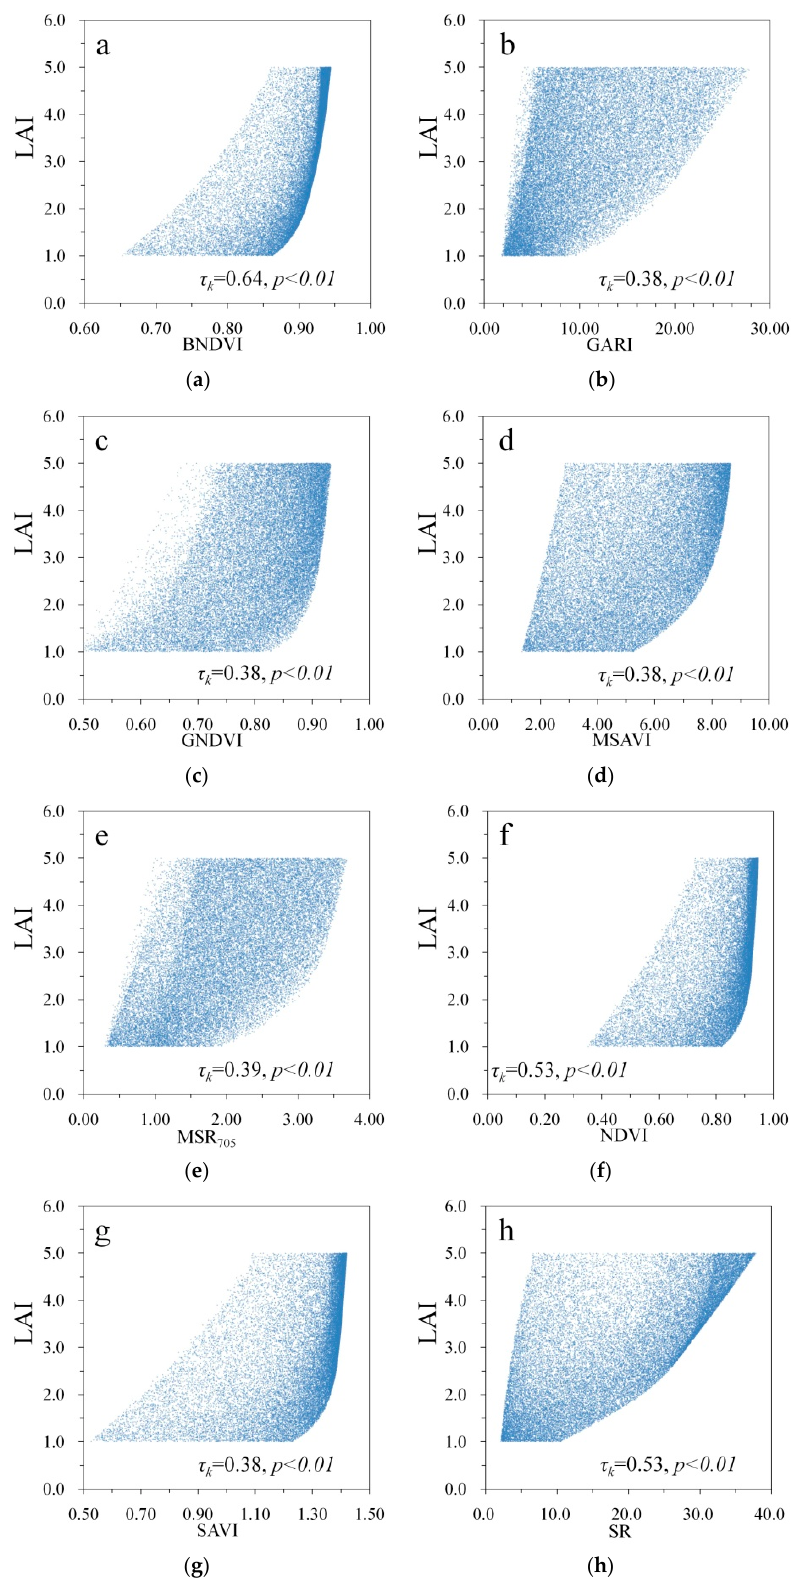
Figure 6. Correlation between LAI and the selected vegetation indices according to PROSAIL simulations: ( a ) BNDVI, ( b ) GARI, ( c ) GNDVI, ( d ) MSAVI, ( e ) MSR 705 , ( f ) NDVI, ( g ) SAVI, ( h ) SR. Kendall’s correlation coefficient τ k and the significance level p are given in each plot. Table 4. Kendall’s rank correlation coefficient ( τ k ) between vegetation indices and LAI for model simulations and field-measured data. All correlations were statistically significant ( p < 0.01).